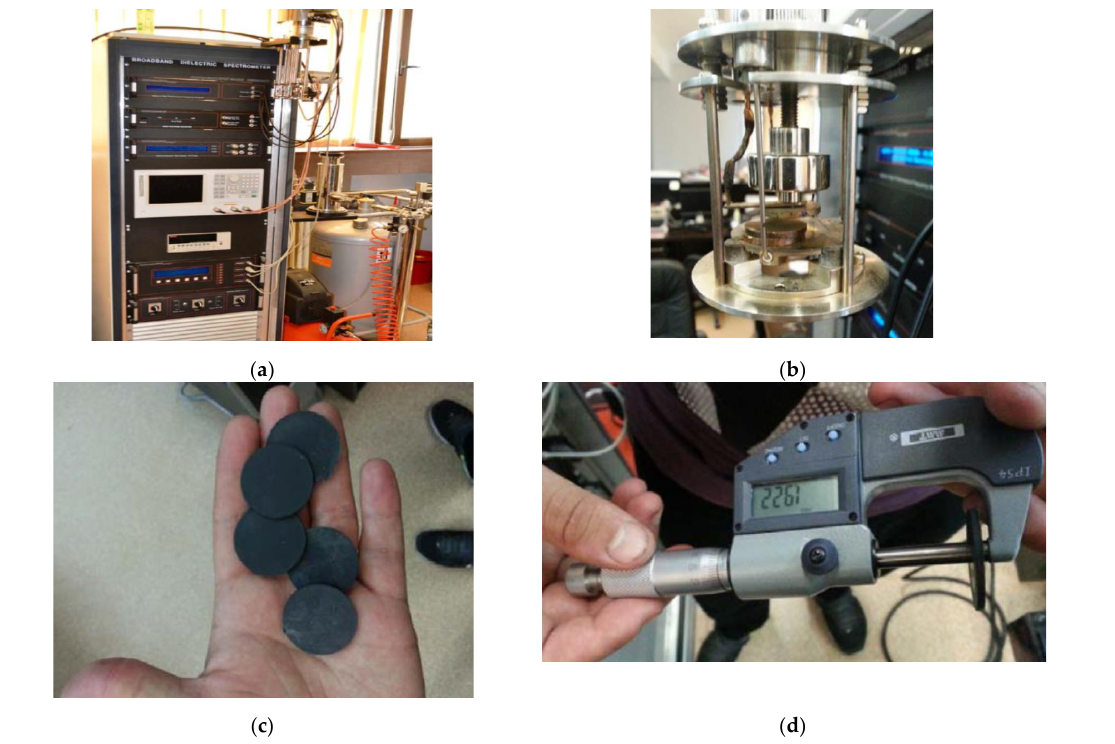
Figure 14. Measurement setup; ( a ) broadband dielectric spectrometer, ( b ) measurement cell, ( c ) manufactured samples, ( d ) measurement of individual sample thickness.